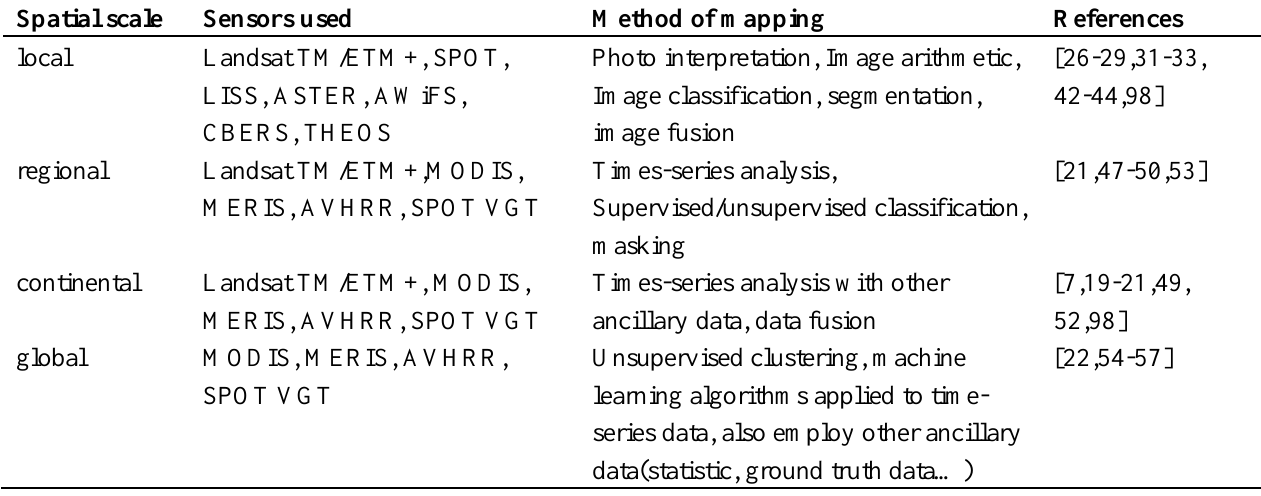
Table 2. Summary of spatial scales, sensors, methods, and example applications in the literature. Spatial